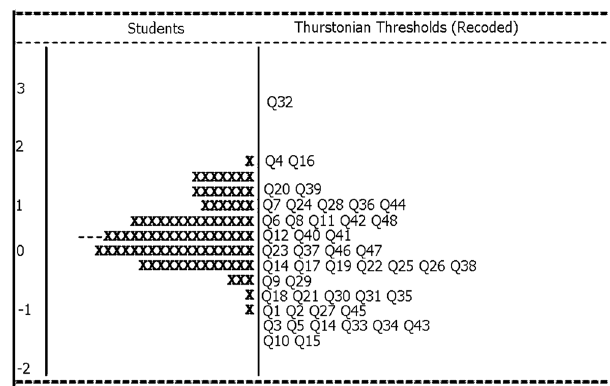
FIG. 2. Wright map of the questionnaire used in the